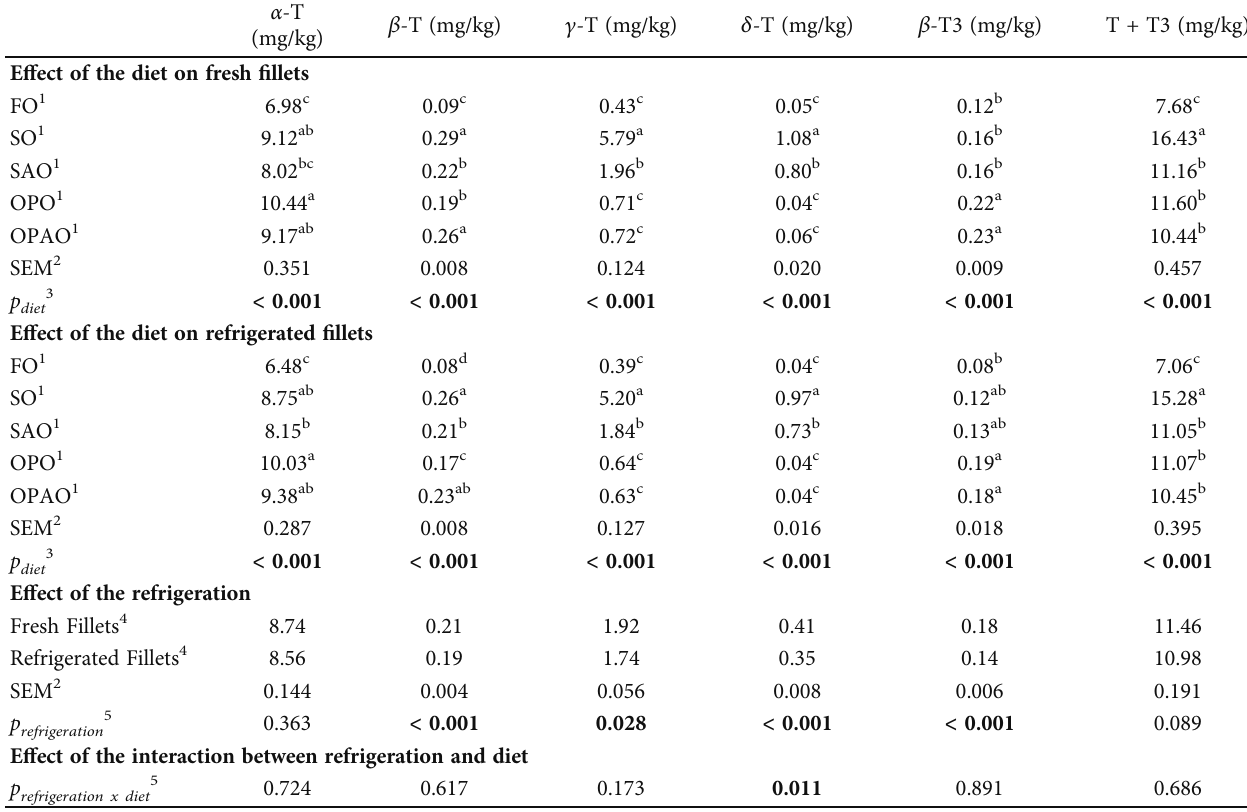
Table 5: Tocopherol and tocotrienol content of fresh and refrigerated fi sh fi llets coming from fi sh fed with the fi ve experimental diets. α -T